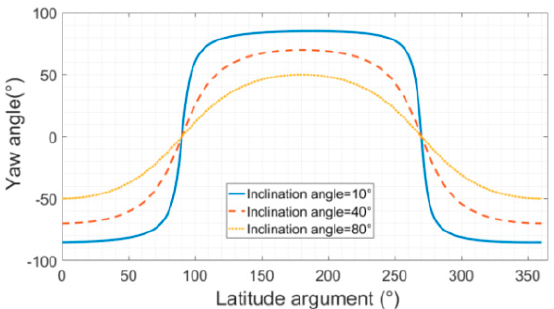
Figure 1. Geo-SAR yaw angles for three different orbital inclination